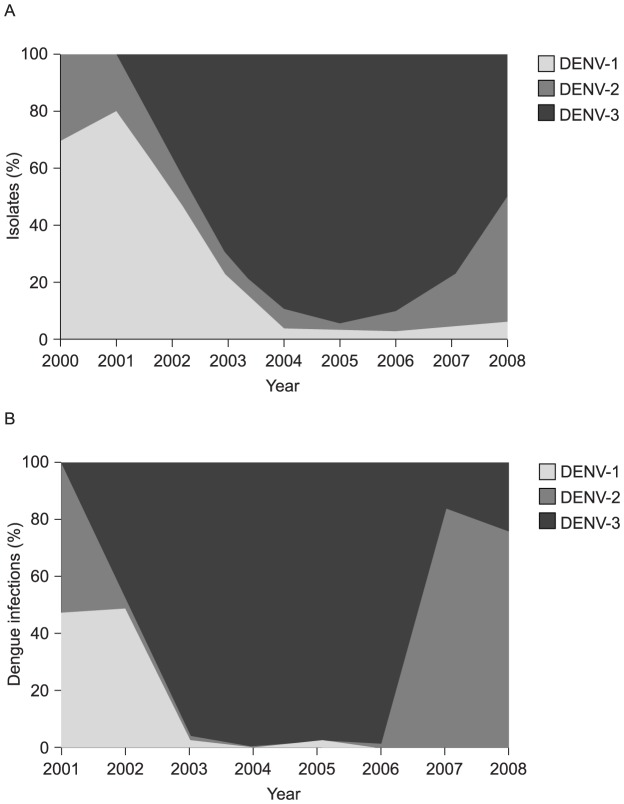
Change in pattern of circulating dengue virus (DENV) serotypes by year, (A) Brazil, 2000–2008 and (B) the Northeast region state of Ceará, 2001–2008.The Brazilian Ministry of Health data from 2000–2008, indicated co-circulation of multiple DENV serotypes with a high proportion of DENV-1 incidence at the beginning of the decade; DENV-3 became predominant from 2003 and DENV-2 was important from 2007. DENV-4 was not present in Brazil until 2011. A similar pattern was observed in the Northeast region state of Ceará. (A: data supplied by Teixeira MG, 2012; B: Cavalcanti 2011 [39]).